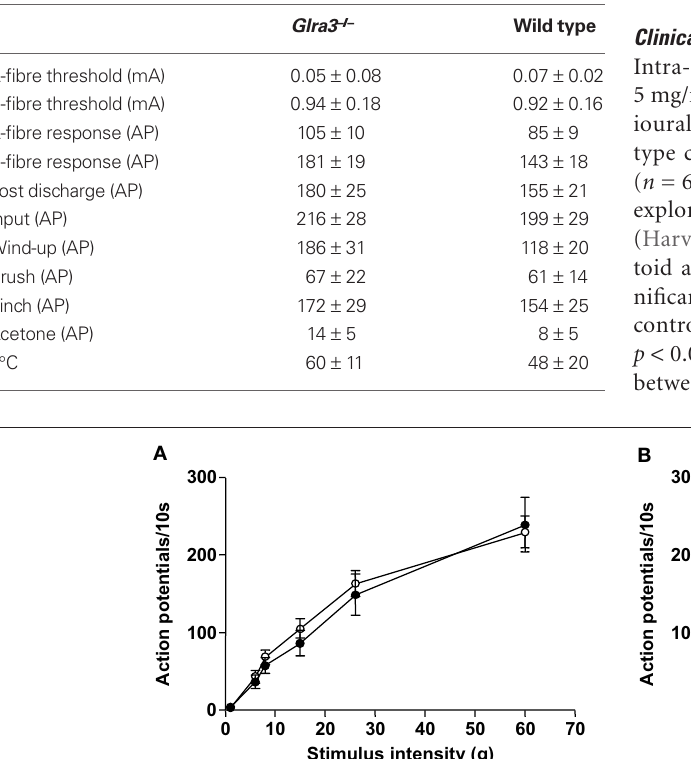
Table 1 | Glra3 − / − mice show no alteration in their neuronal responses to multimodal stimuli. Data are presented as mean ± SEM for deep dorsal horn neurones recorded in Glra3 − / − ( n = 27) and wild-type mice ( n = 22). AP represents the mean number of action potentials in response to either a peripheral electrical or 10-s natural